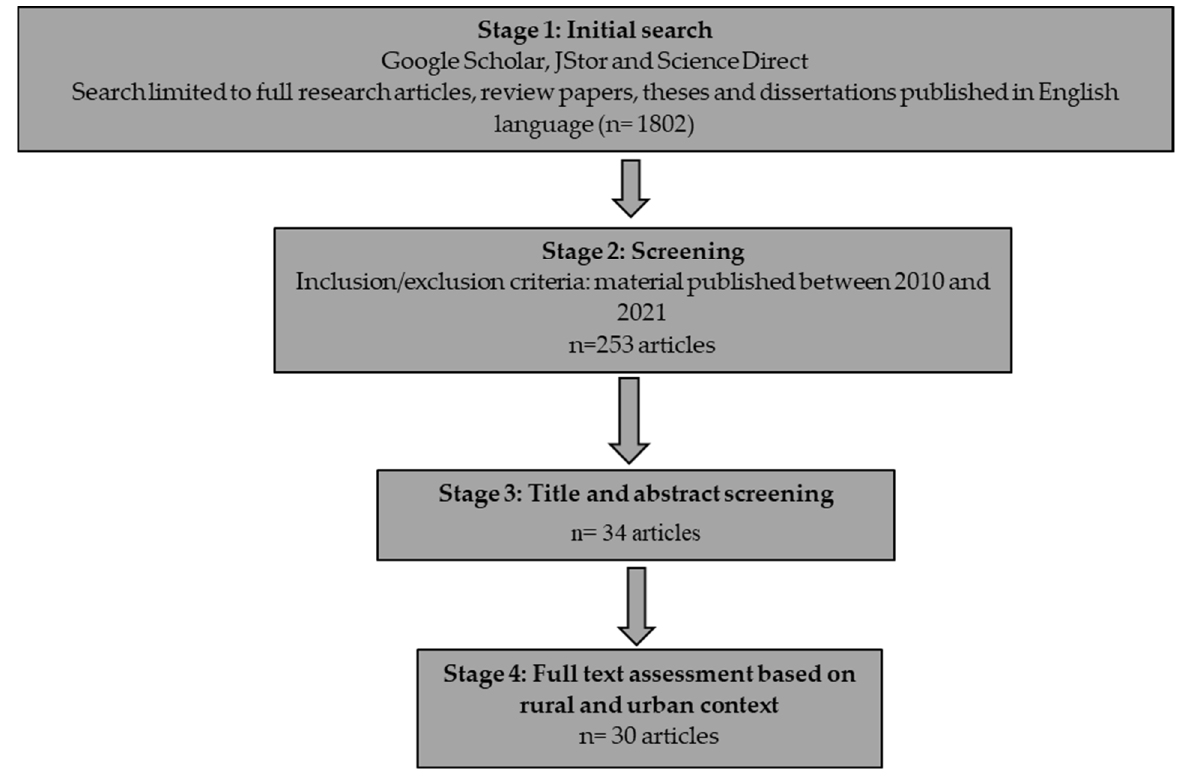
Figure 1. Search procedure and screening process. Source: Authors’ conceptualisation. Table 1. Breakdown of literature sources included in the review.